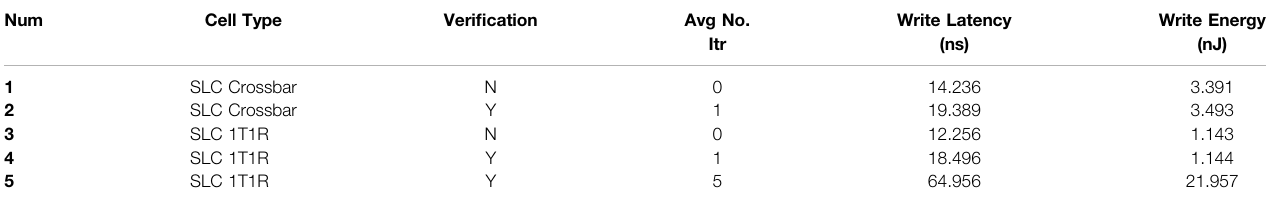
TABLE1| Theeffectofsingleveri fi cationandmultipleveri fi cationonlatencyandenergyofcrossbarandSLC1T1Rarchitecture.Itemnumber1doesnothavetheveri fi cation methodafterwriting,whereasitemnumber2hasonlyoneiterationofveri fi cation.Last,itemnumber3hasveri fi cationwith fi vetimesiteration.Thereasonbehinddifferent numbers of iteration is due to different underlying physics.